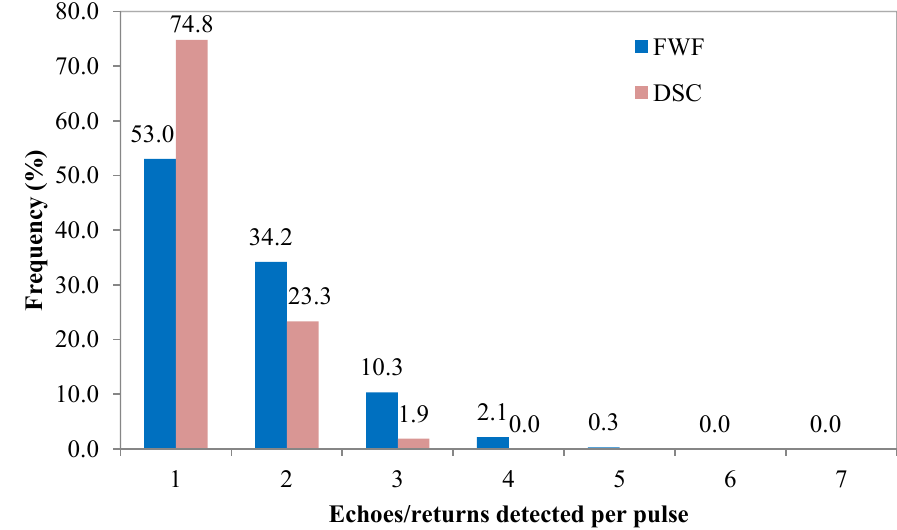
Figure 3. Proportion of total detected echoes (returns) per